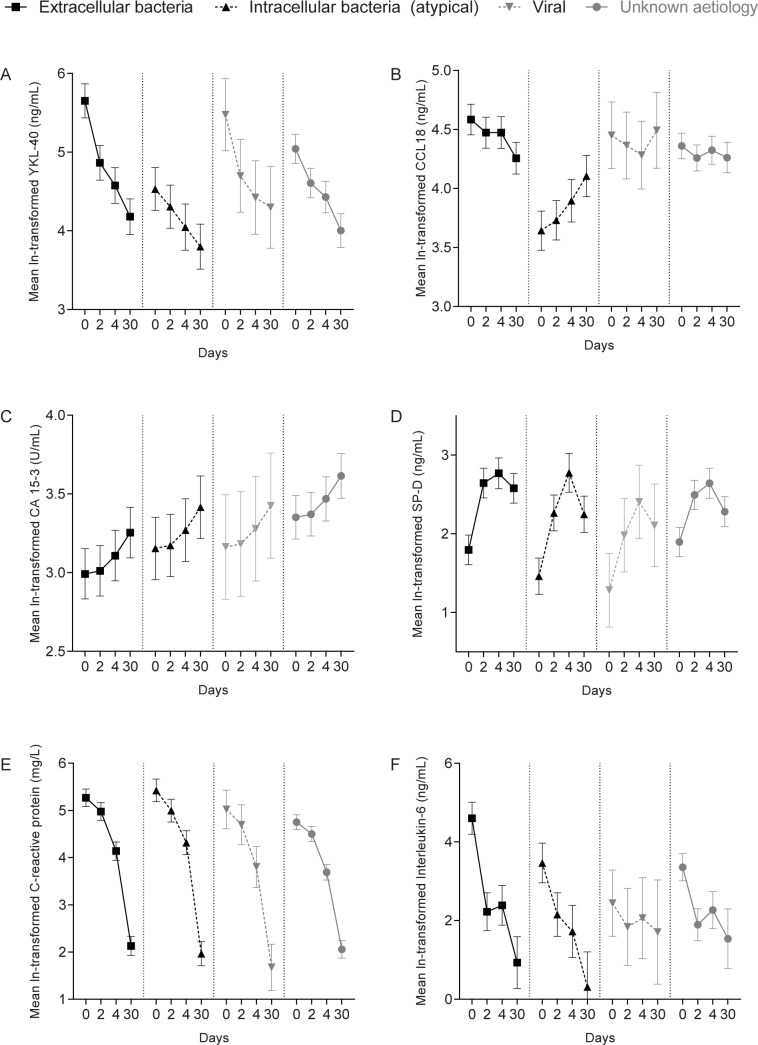
Change in log normally-transformed pulmonary marker levels over time for each aetiological group.Data are shown as estimated marginal means with 95% confidence intervals.